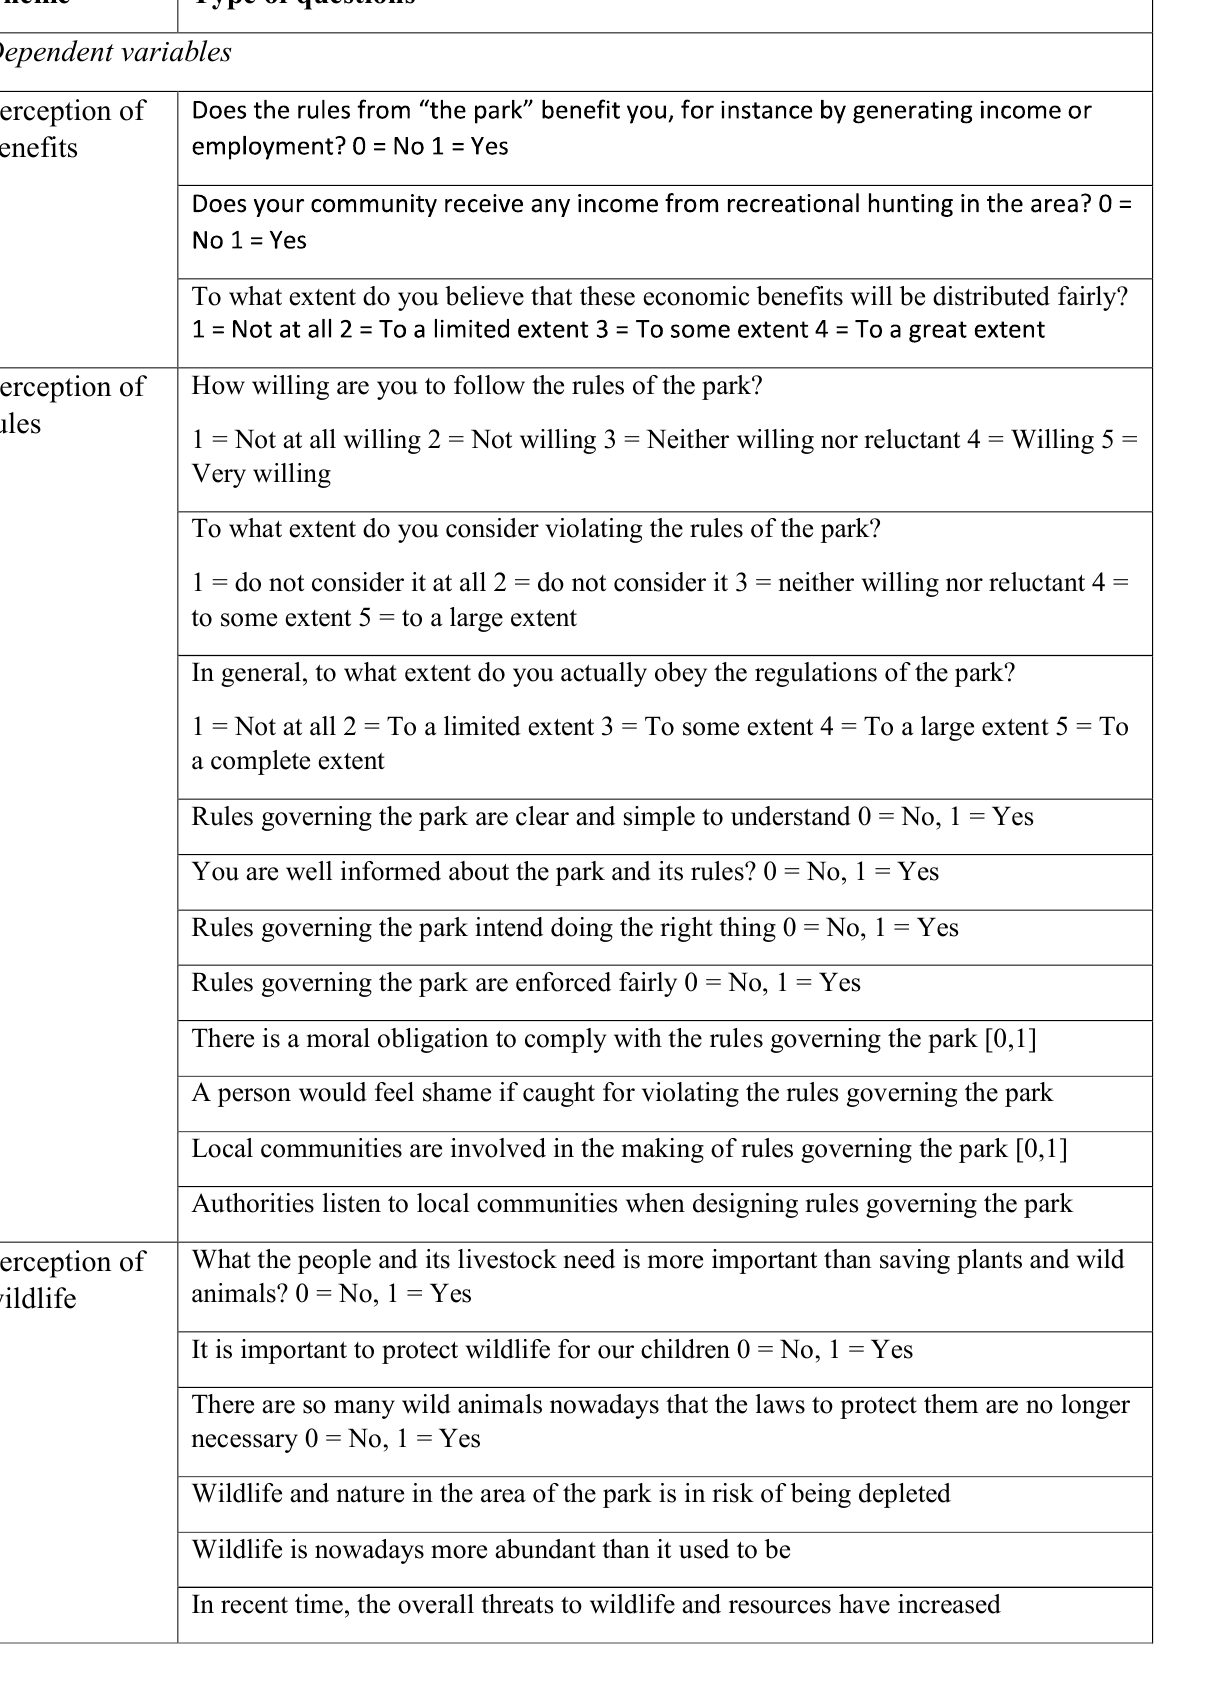
Table A1.1 . Type of question asked by Table A1: Type of question asked by theme